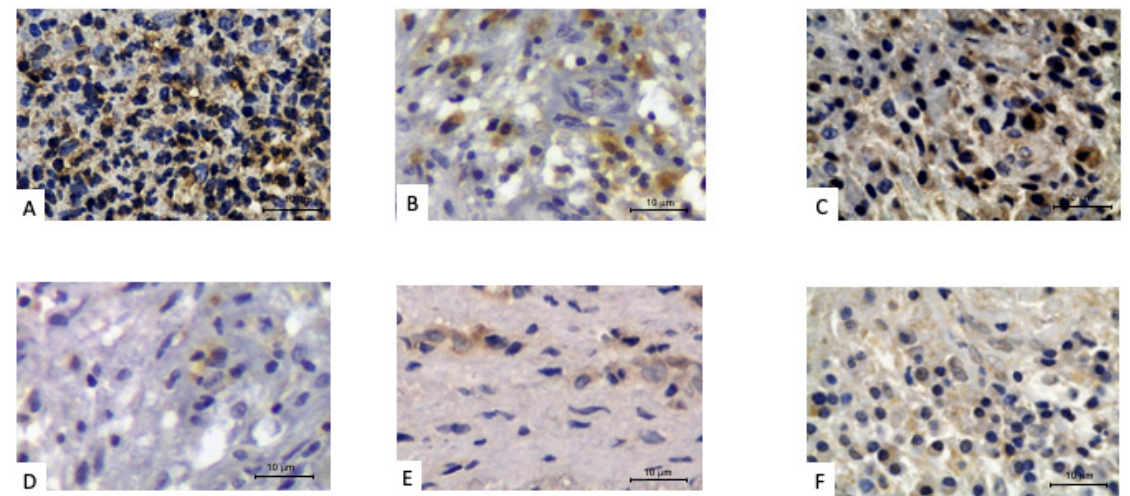
Figure 1. Periradicular granulomas with positive immunoperoxidase staining for pro-inflammatory cytokines. Older patient: ( A ) IL-1 β , ( B ) IL-6 and ( C ) TNF- α . Younger/middle-age adult patient: ( D ) IL-1 β , ( E ) IL-6 and ( F ) TNF- α .